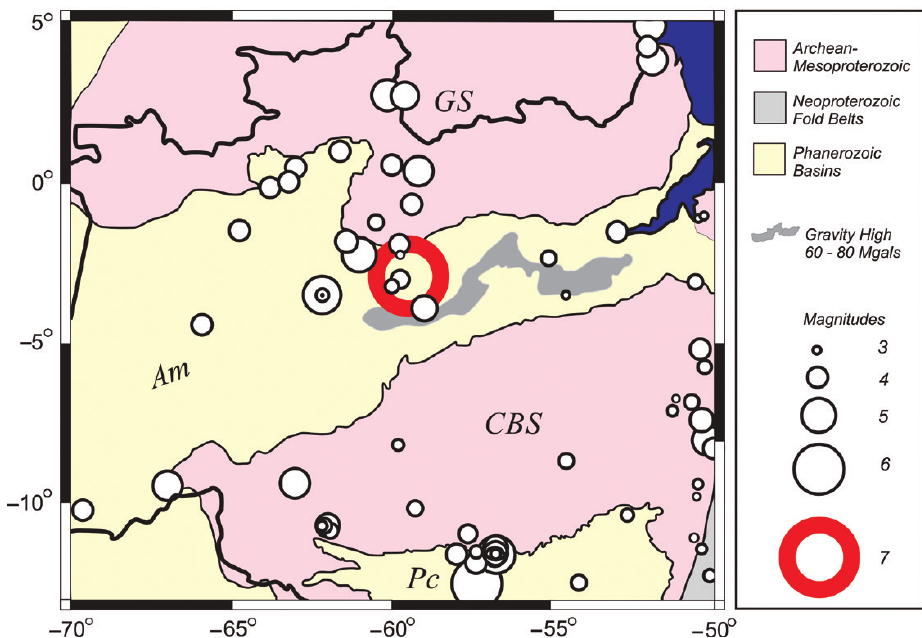
Fig. 2 - Seismicity, geology and gravity anomalies of part of the Amazon region. Epicenters (white circles, from the Brazilian Catalog) have magnitude ≥ 3.0. Large ring is the 1690 earthquake. Solid line is the boundary between the Amazon Basin (Am) and the Guiana (GS) and Guapore (CBS) shields. Pc is the intracratonic Parecis Basin. The continuous grey shape marks the E-W trend of high gravity, from Sa